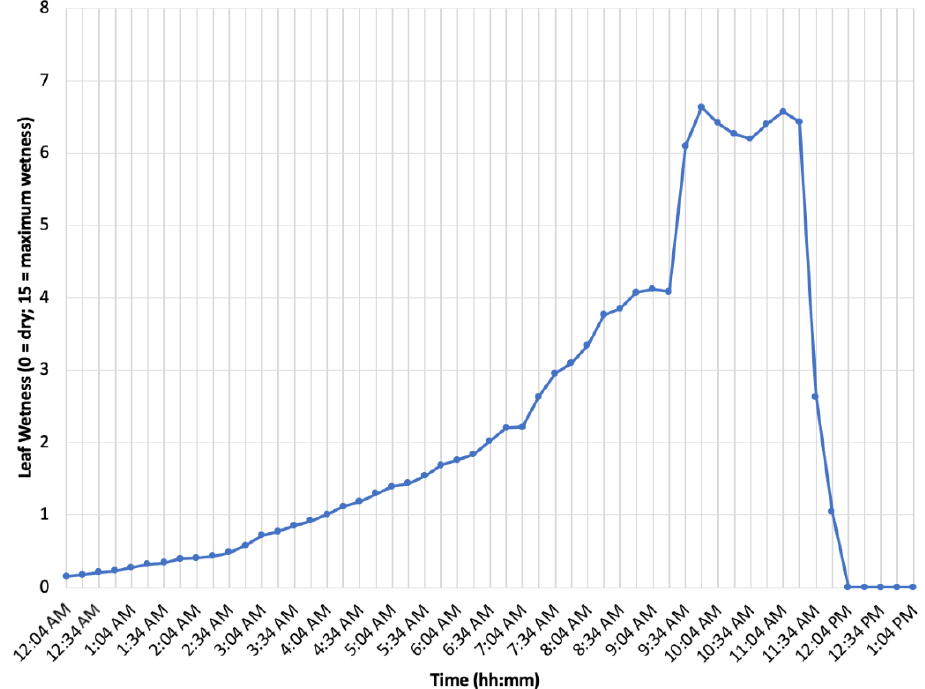
Figure 8. Trend of average leaf wetness values recorded on 11 February, i.e., the day the mowing treatments were performed.